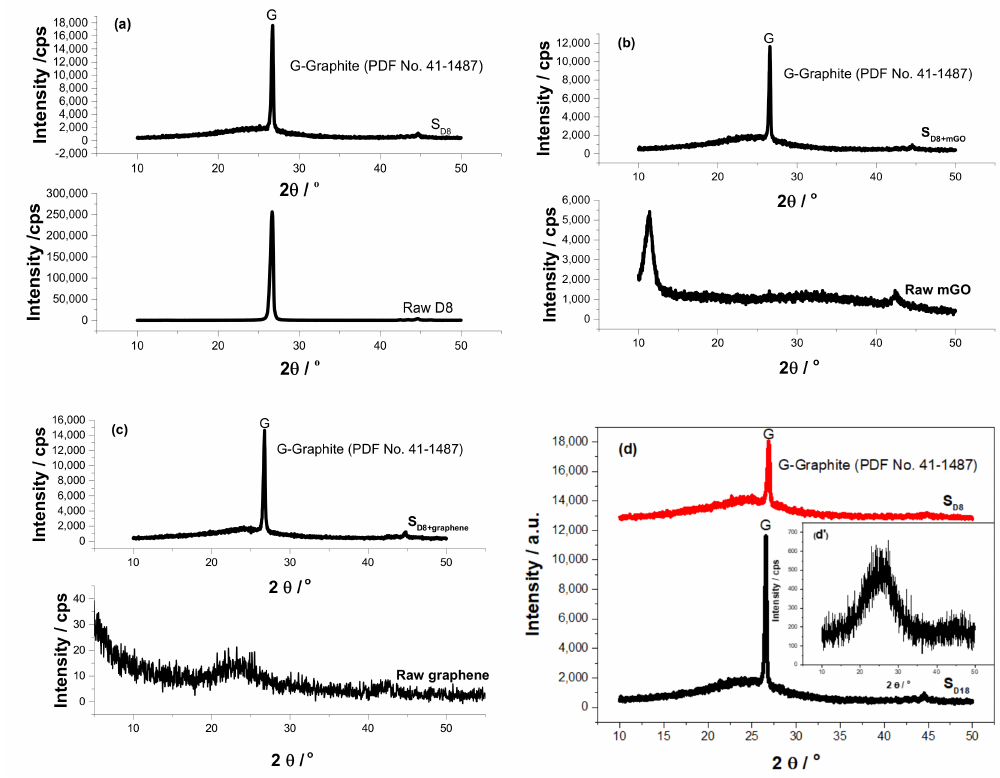
Figure 6. XRD of residual char, including: ( a ) S D8 , ( b ) S D8+mGO , ( c ) S D8+graphene , ( d ) comparison between SD8 and S D18 , and ( d’ ) sample without